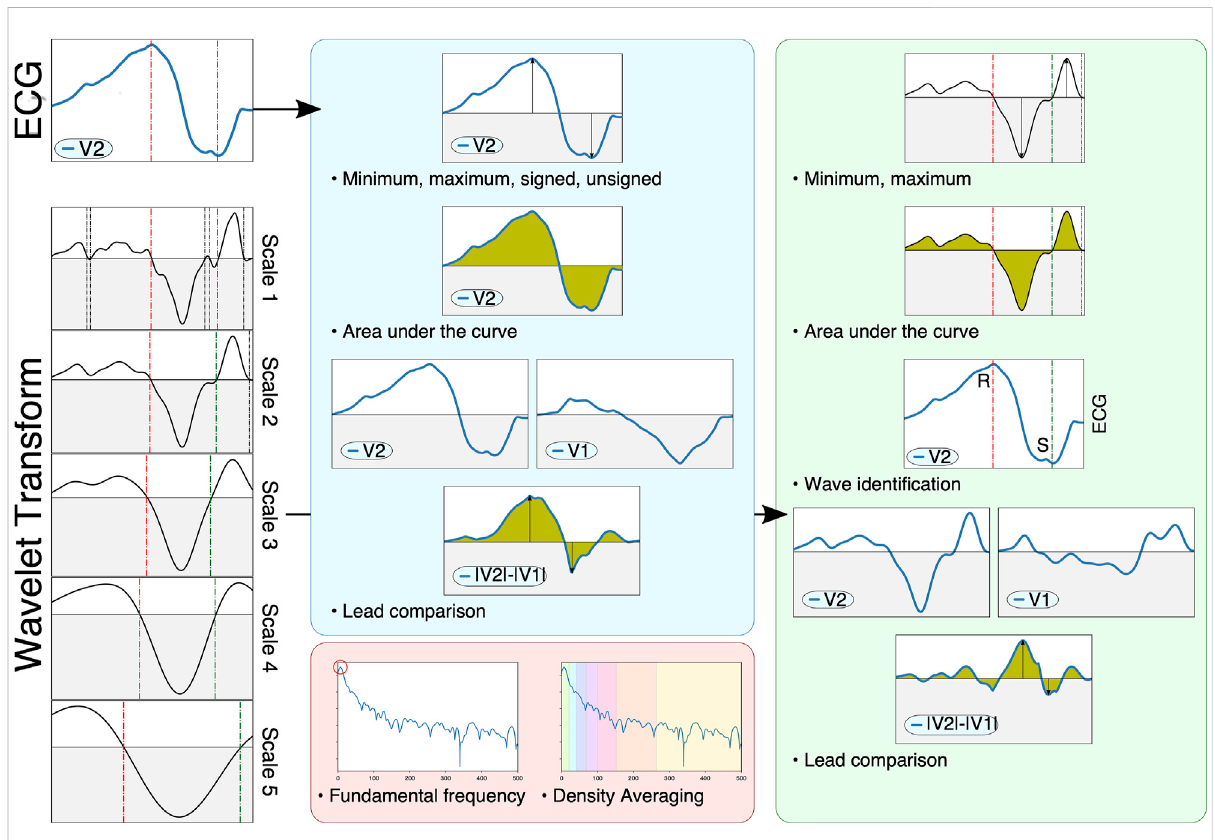
FIGURE 3 Schematicrepresentation ofthefeatureextractionpipeline.The ECG(left,top)and itswavelettransform(left,scales onethrough5) areusedto compute signal-based (blue), wavelet-based (green) and spectral-based (red) features. Signal-based features measure the raw ECG, computing extrema, areas or characteristics computed through pairwise lead comparison. Wavelet-based features also compute said markers, but also identify important fi ducialsthroughzero-crossings(e.g.differentQRSwavessuchastheRandSwaves,shownontheleftasgreenandreddottedlines). Finally, spectral information employs Welch ’ s periodogram to obtain features based on the signal ’ s power spectral